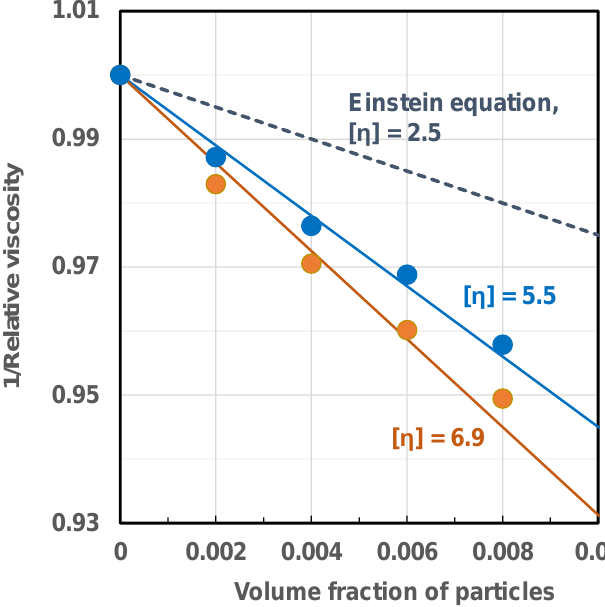
Figure 4. Plots of r  / 1 versus  data for polystyrene latex suspensions consisting of negatively Figure 4. Plots of 1/ η r versus φ data for polystyrene latex suspensions consisting of negatively charged charged particles of diameter 250 nm suspended in KCl solutions. particles of diameter 250 nm suspended in KCl